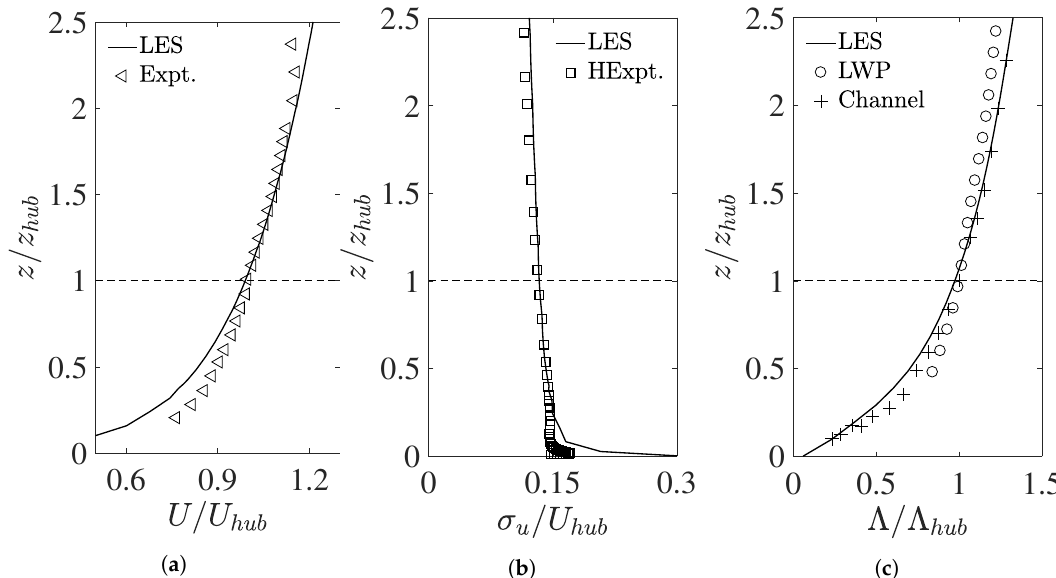
Figure 2. Flow characteristics and validation with experiments of a simulated neutral atmospheric boundary layer (ABL) profile ( Re τ 5 10 8 ) using wall-modeled large eddy simulation (LES). ∼ × ( a ) Normalized streamwise mean velocity, U / U hub , ( b ) turbulence intensity, σ u / U hub and ( c ) Normalized integral length scale Λ u / Λ u . The horizontal lines represent turbine hub-height location. hub Expt-Hayat et al. 2019 [39], ( Re τ 9.3 10 3 ); HExpt, wind tunnel experiment from Hutchins et al. ∼ × (2009) [40] ( Re τ 1.9 10 4 ), Channel-Channel flow DNS by Sillerro et al. (2014) [42] ( Re τ ∼ × and LWP-Leipzig wind profile, Lettau (1950)